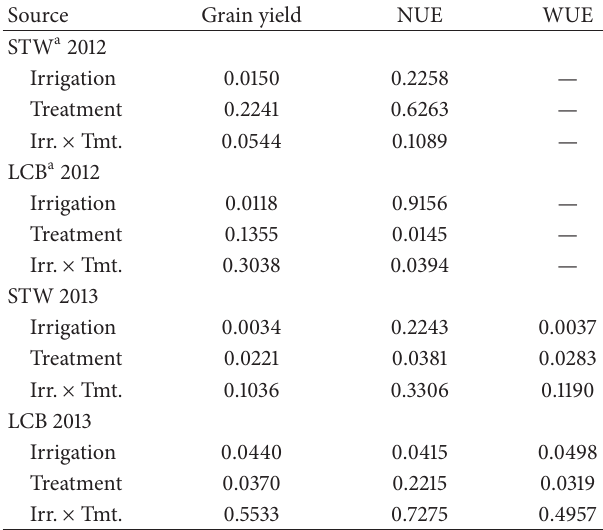
Table 4: 𝑃 value results from the analysis of variance for the main and interactive effects of irrigation (Irr.) and preplant fertilizer treatment (Tmt.) on grain yield, N use efficiency (NUE), and water use efficiency